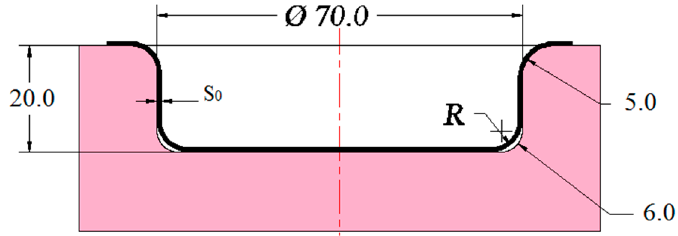
Figure 3. Die profile. Figure 3. Die Table 1. Properties of materials.